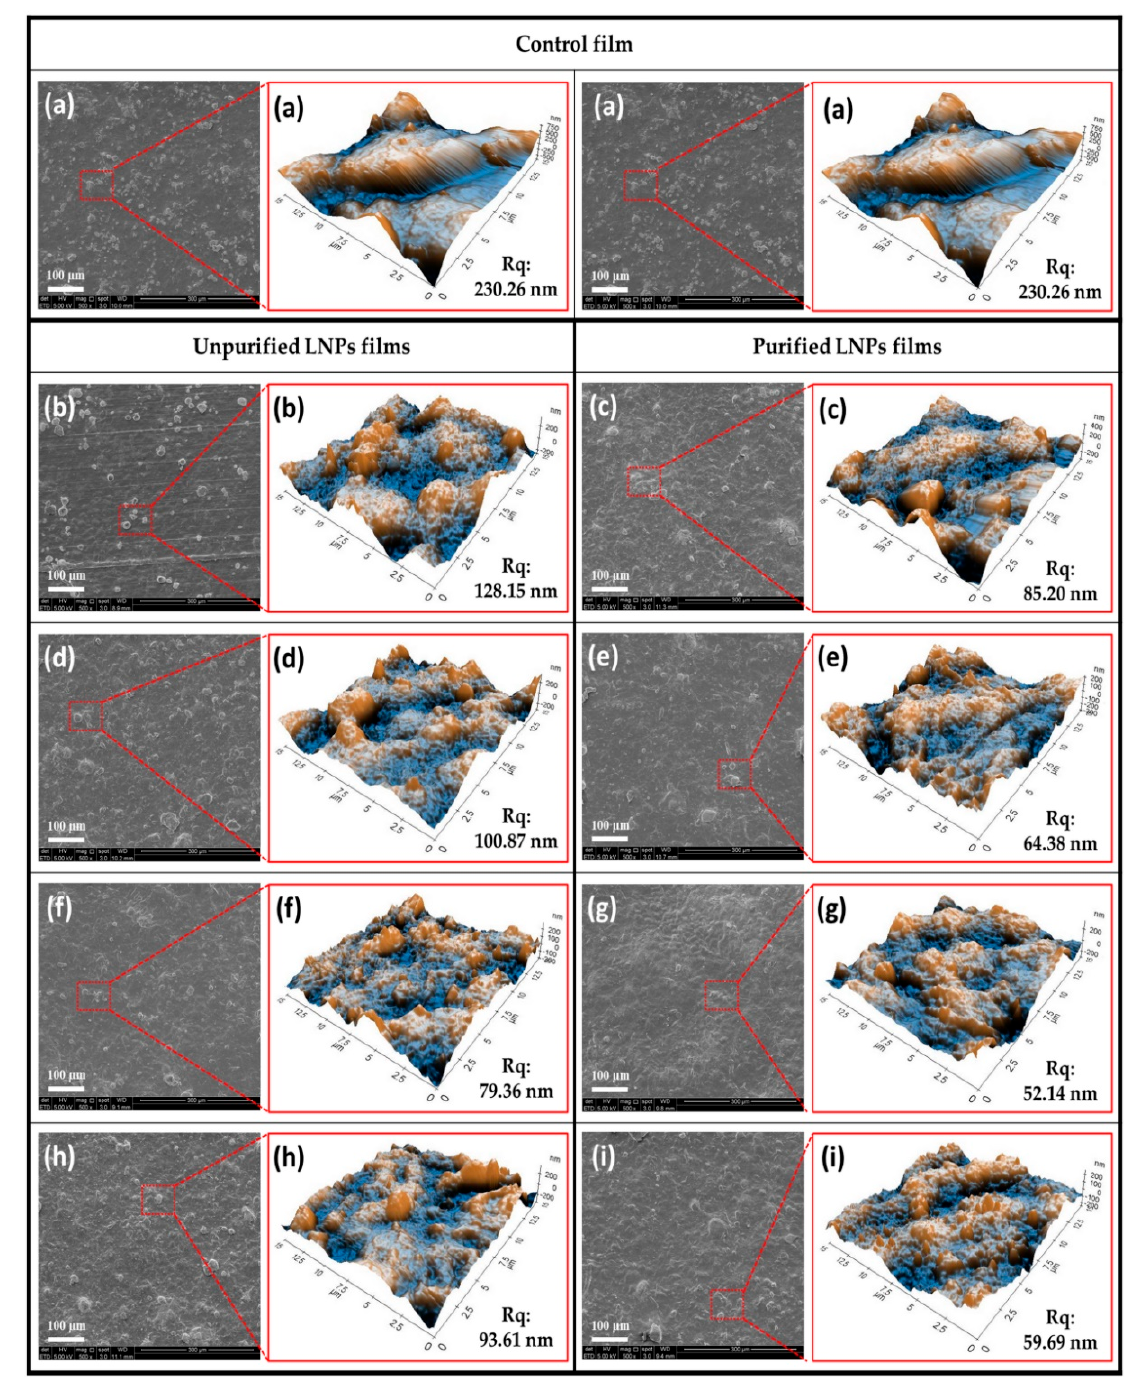
Figure 2. Surface morphologies by SEM and surface roughness by AFM of the bioplastic films for ( a ) control; unpurified and purified LNPs, ( b , c ) 1%, ( d , e ) 3%, ( f , g ) 5%, and ( h , i ) 7%.